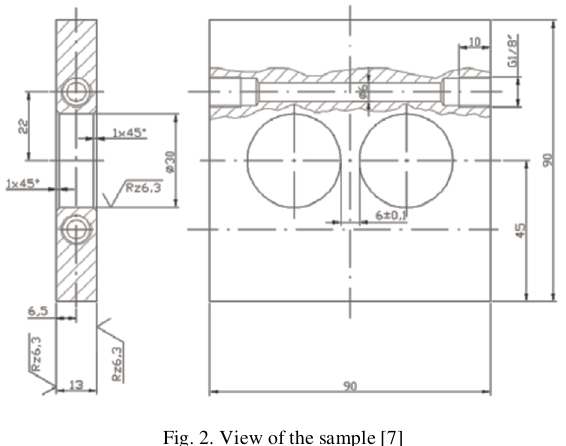
Fig. 2. View of the sample